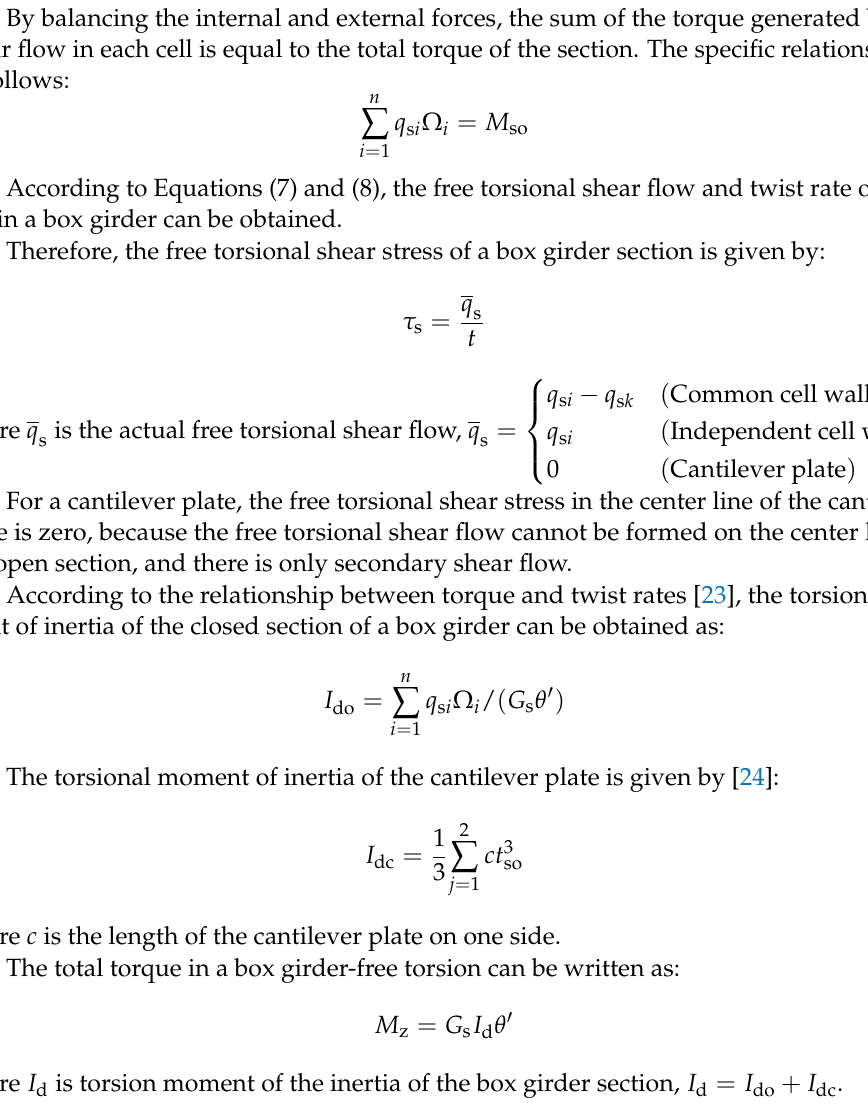
Figure 2. Free torsion of multi-cell closed section.